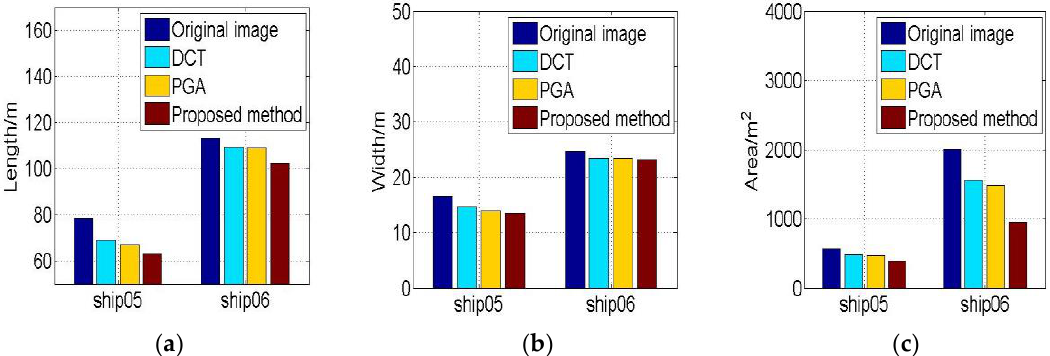
Figure 19. The geometrical features of refocusing ship05 and ship06. ( a ) Lengths of ships; ( b ) Widths of ships. ( c ) Areas of ships.